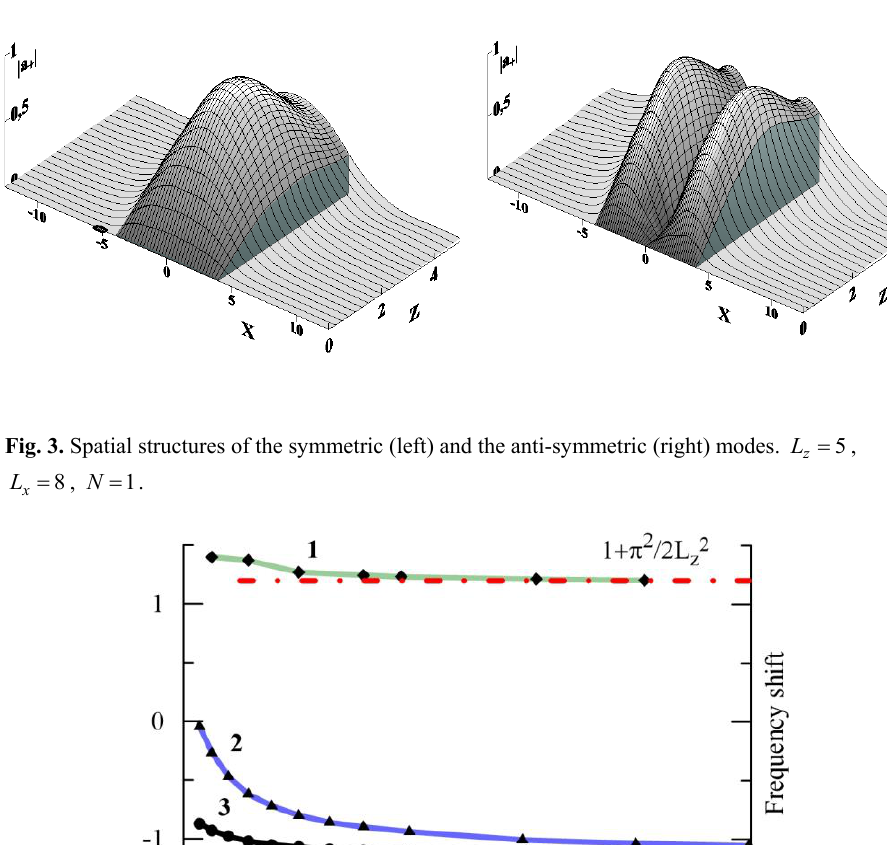
Fig. 4. Dependence of the frequency shift of the higher-frequency (1), lower-frequency anti- symmetric (2) and symmetric (3) modes of the Bragg resonator on the Fresnel parameter N . Dot- dashed line denotes the asymptotic values determined by relation (10). 5